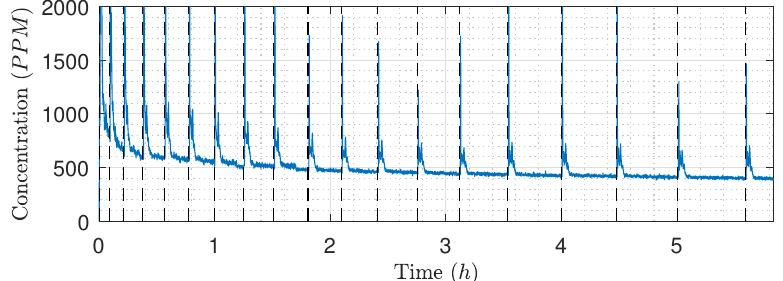
Figure 17. Inlet concentration during the validation experiment (Figures 15 and 16), according to the TD-4100XD. The black dashed lines indicate filtration termination and backwashing